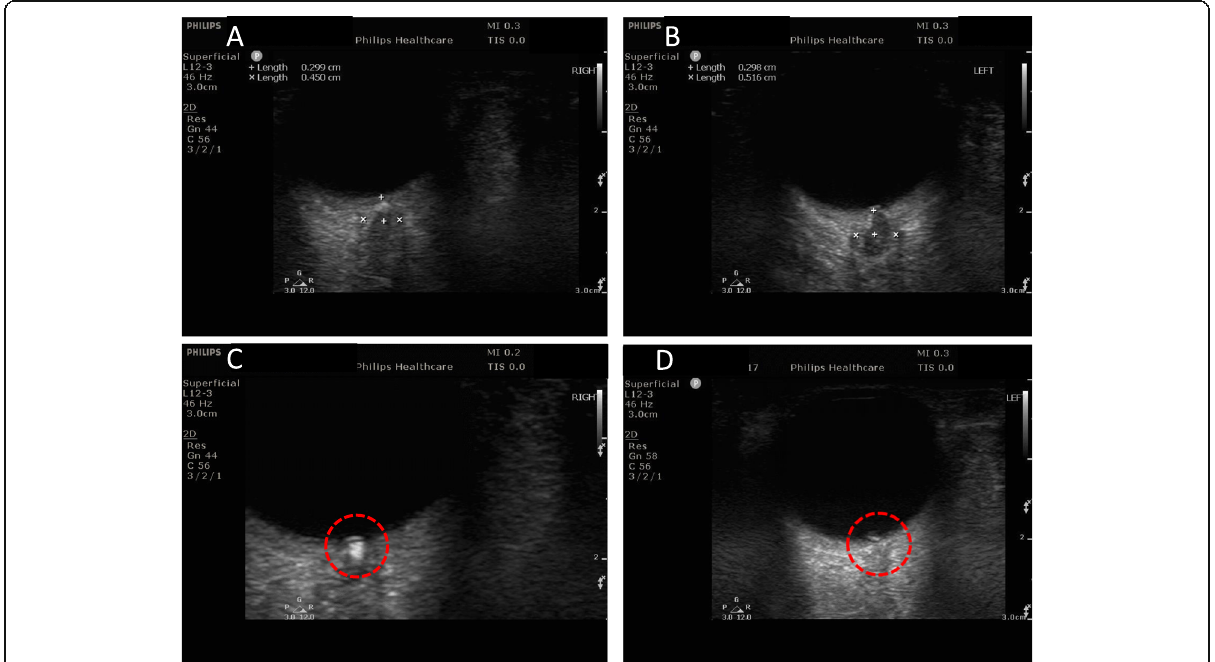
Fig. 1 Transorbital Ultrasound Findings in suspected IIH revealing Optic Disc Drusen. B-Mode transorbital sonography ruled out enlargement of the optic nerve sheath diameter as measured 3 mm posterior to the globe (right 0.45 cm, left 0.52 cm, normal limits < 0.51 cm for European population [2]) due to underlying IIH (Panels a & b ). Calcified optic disc drusen appeared as hyperechoic, highly reflective structures with posterior acoustic shadow (red-circle; Panels c & d )